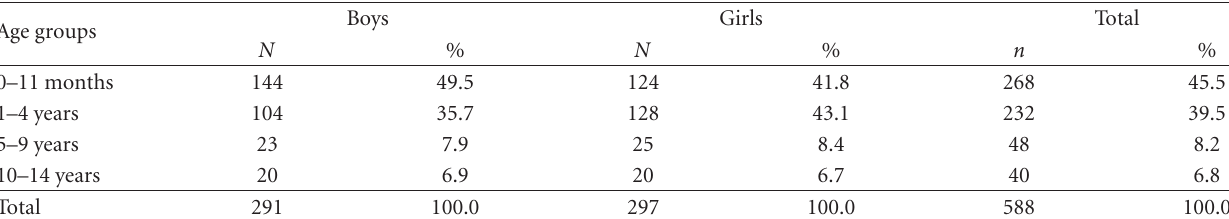
Table 1: Age distribution of deceased children ( n = 588).